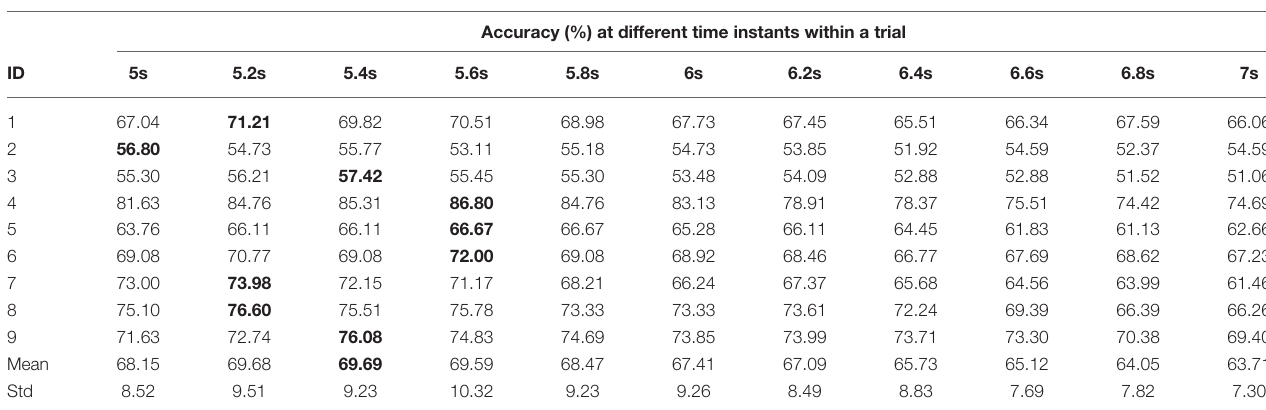
TABLE 9 | Performance of inter-subject learning for CA opt (highlighted in bold for each subject